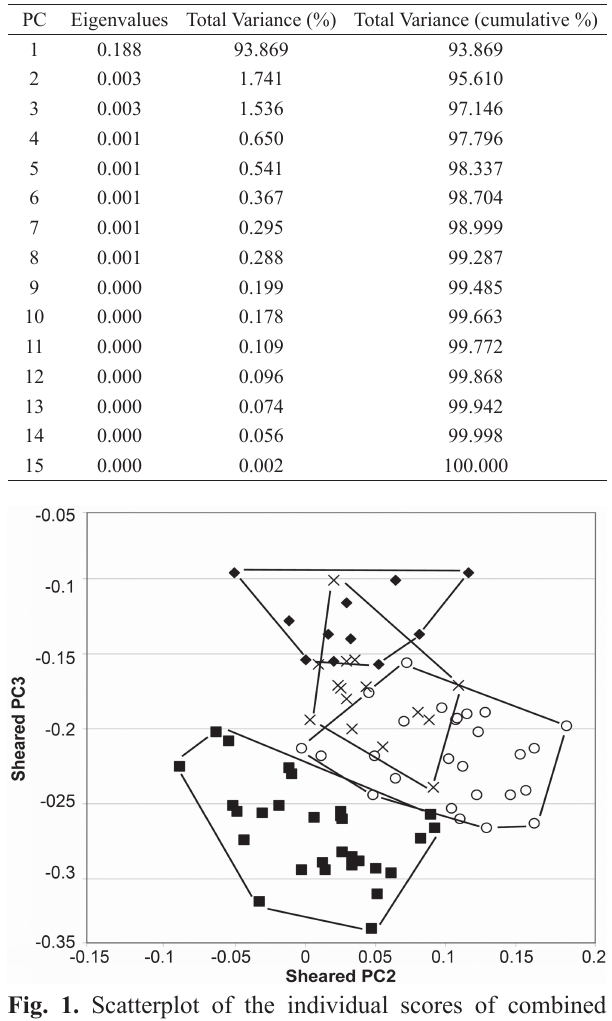
Tab. 2. Sheared Principal Component loadings of the morphometric measurements used in the Principal Component Analysis. Higher absolute values are bolded.